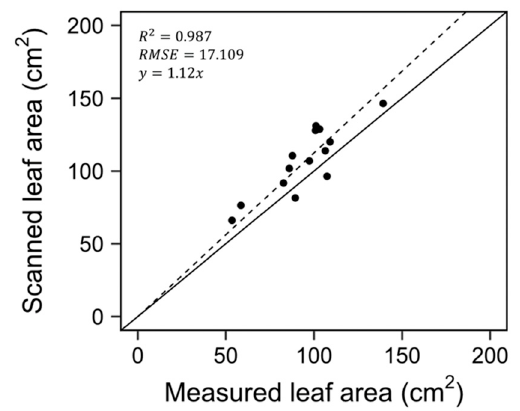
Figure 3. Comparison between measured and scanned leaf areas. The total number of leaves was 14, and the continuous line was a 1:1 match line.